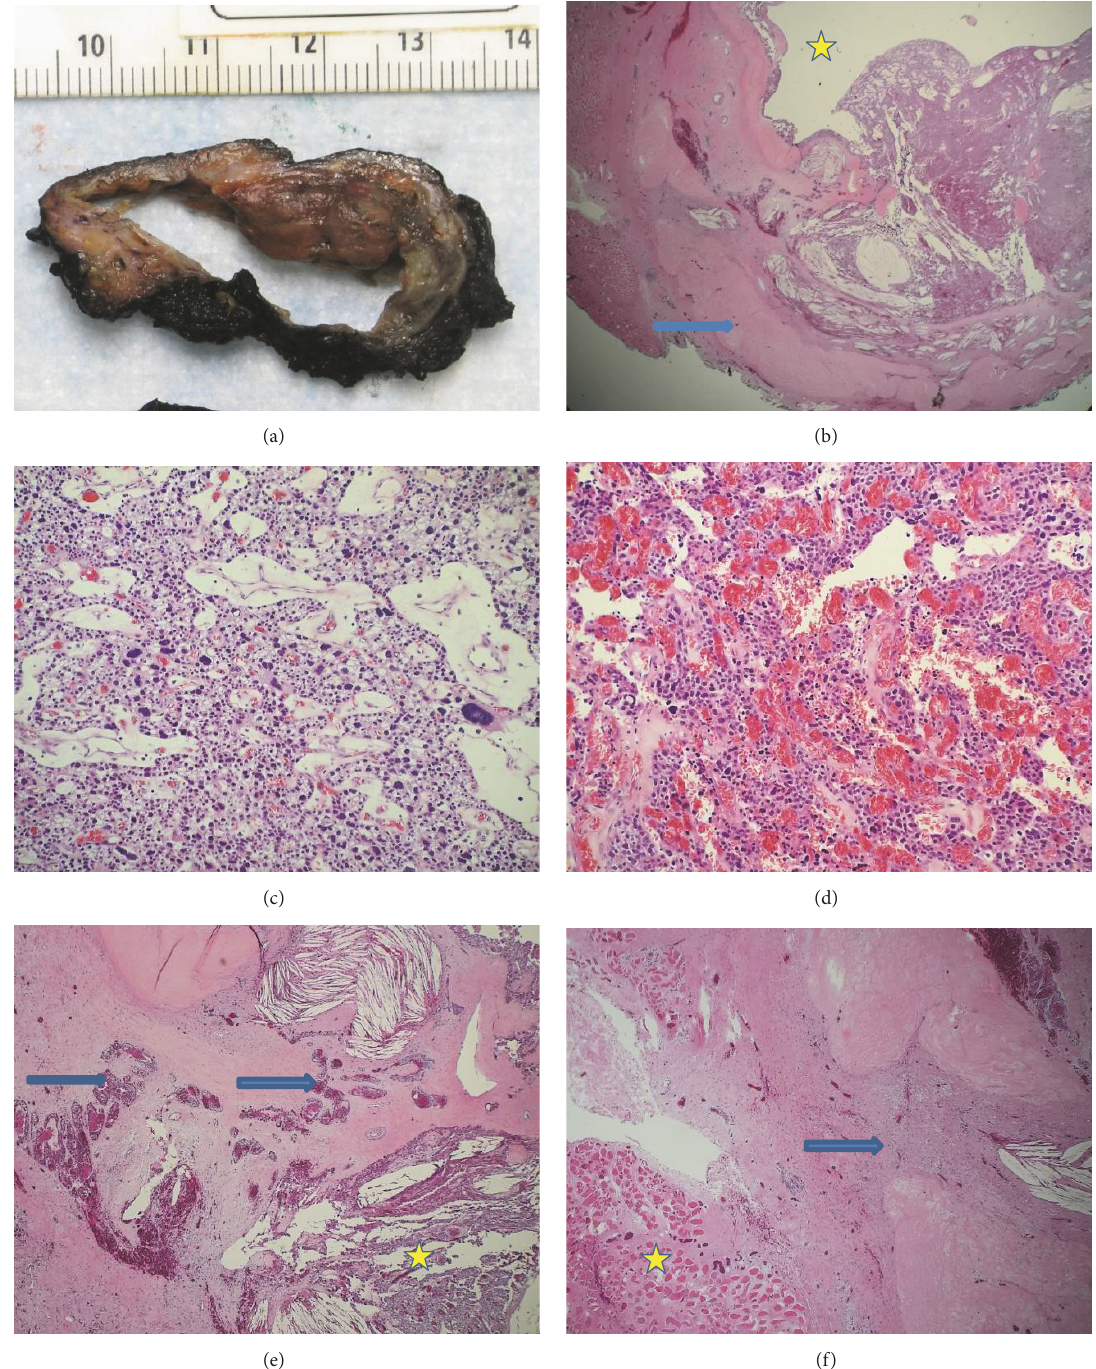
Figure 1: The tumor has red brown solid part and a cystic space grossly (a). It has a thick fibrous capsule (blue arrow) and cystic space (yellow star) (b), bizarre atypical cells (c), and vascular proliferation (d). It also shows extensive foreign body type reactions surrounding the capsule (yellow star)and entrappedgroups of normal appearing parathyroid cells(bluearrows) (e).Thereis adherenceof strapmuscles(yellow arrow) to the capsule and a possible needle tract from previous FNA (blue arrow) (f). Magnification for (b) is X20; (c), (d) X100; and (e), (f)